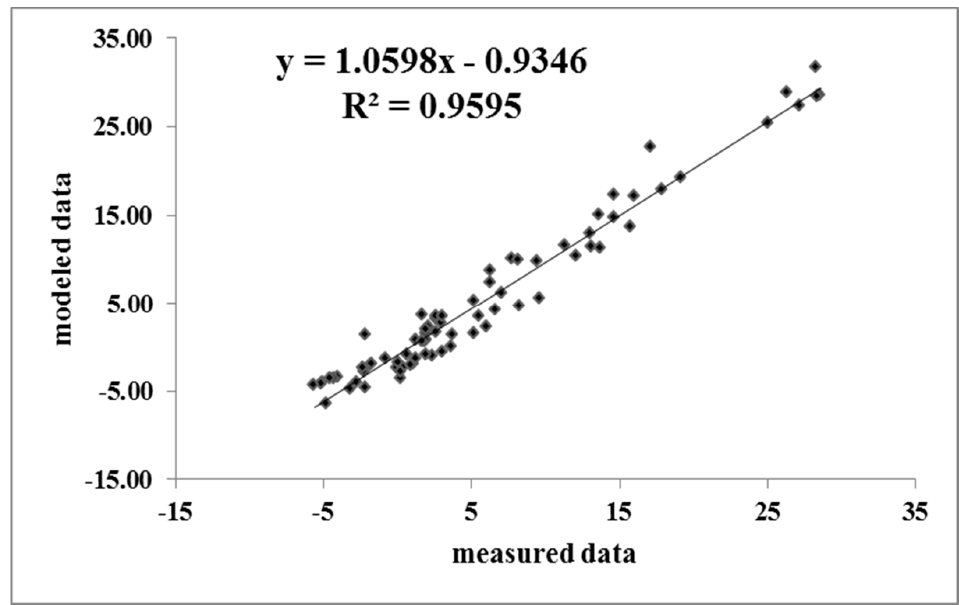
Figure 7. Relationship between the measured and modeled data of indoor temperature of the greenhouse.